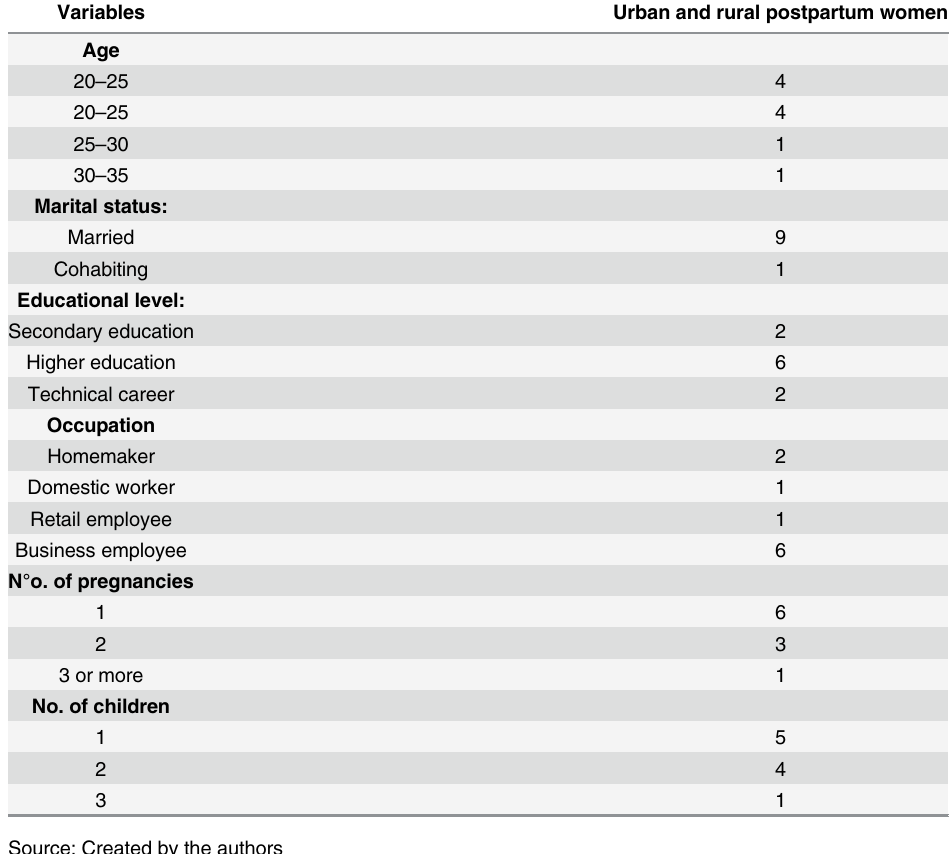
Table 3. Socio-demographic characteristics of the sample: urban and rural postpartum women.